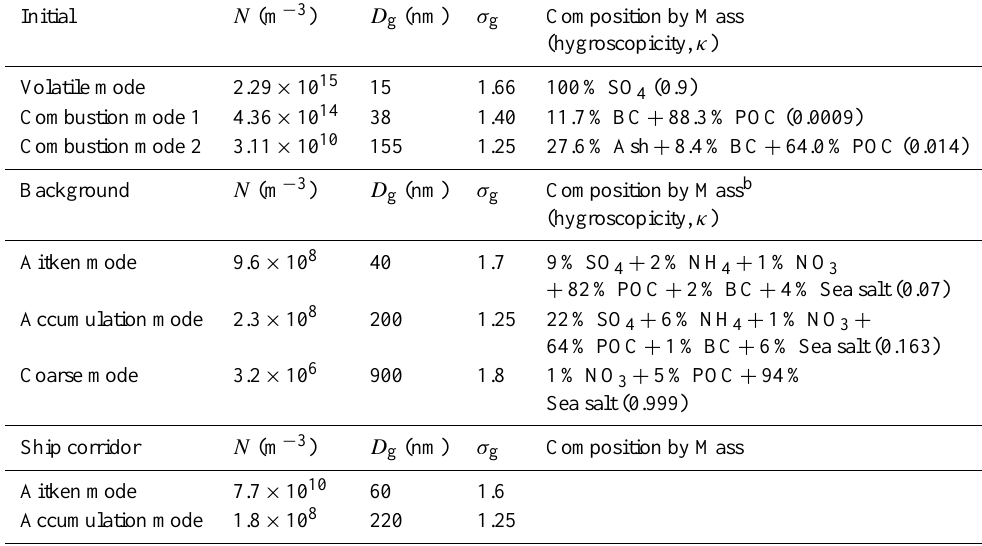
Table 3. Aerosol initial, background and ship corridor conditions a